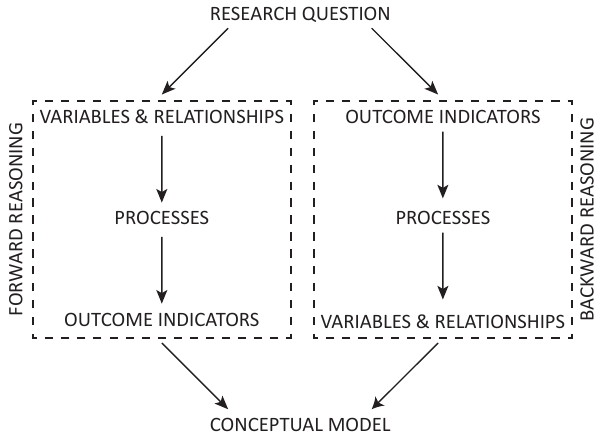
Figure 1. Backward-reasoning process (adapted from Schlüter et al.,